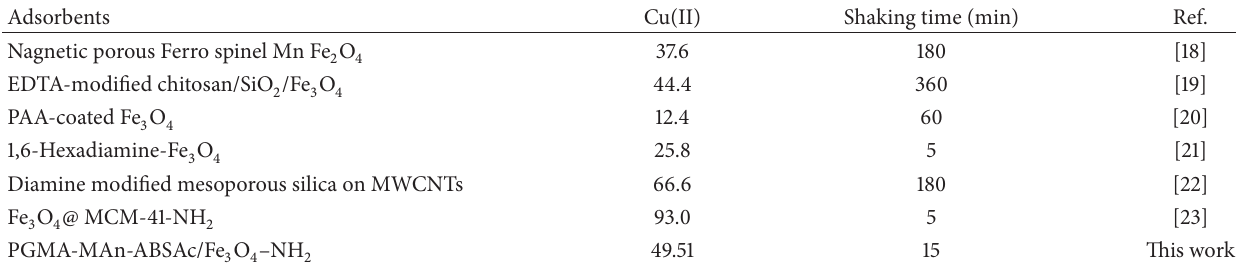
Table 2: Comparison of adsorption capacity by various adsorbents for Cu(II) ion